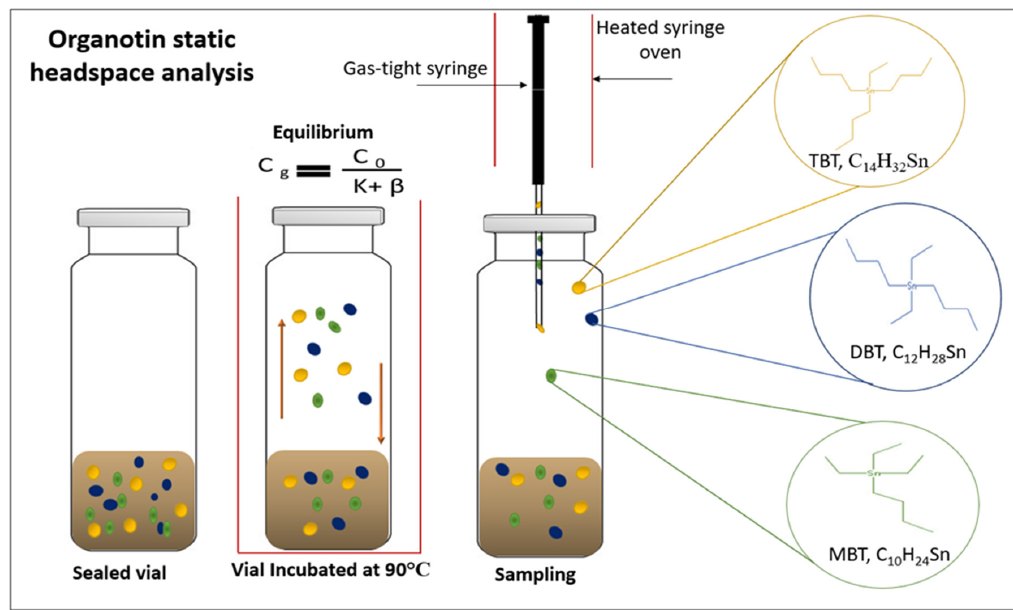
Figure 1. Simple representation of static headspace analysis of organotin compounds TBT, DBT and MBT from sediment. The vapor-phase of the extraction is represented illustrating the equilibration of analytes between a non-volatile solid phase, after heating and agitation of the sample the equilibrium (Cg = (Co)/(k + β ) ((Cg) the concentration of the analyte, (Co) analyte concentration, (K) the partition coefficient, ( β ) volume ratio) [23], of the compounds is reached and the vapor phase mixture which contains fewer interfering compounds is transferred to the GC for analysis.